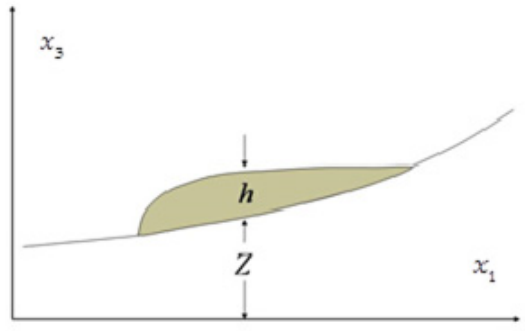
Figure 1. Reference system and notation used in the analysis [28].